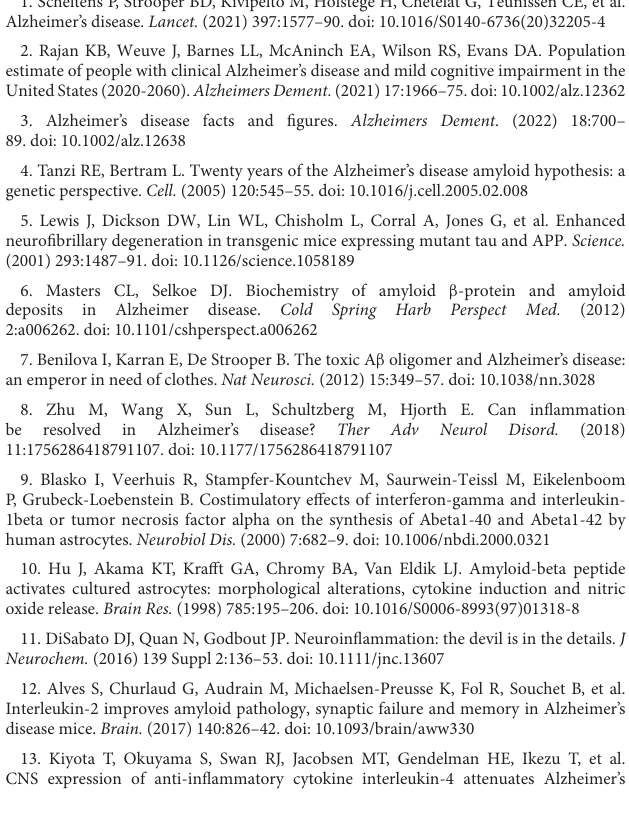
SUPPLEMENTARYTABLE2 Information on drugs targeting these seven hub